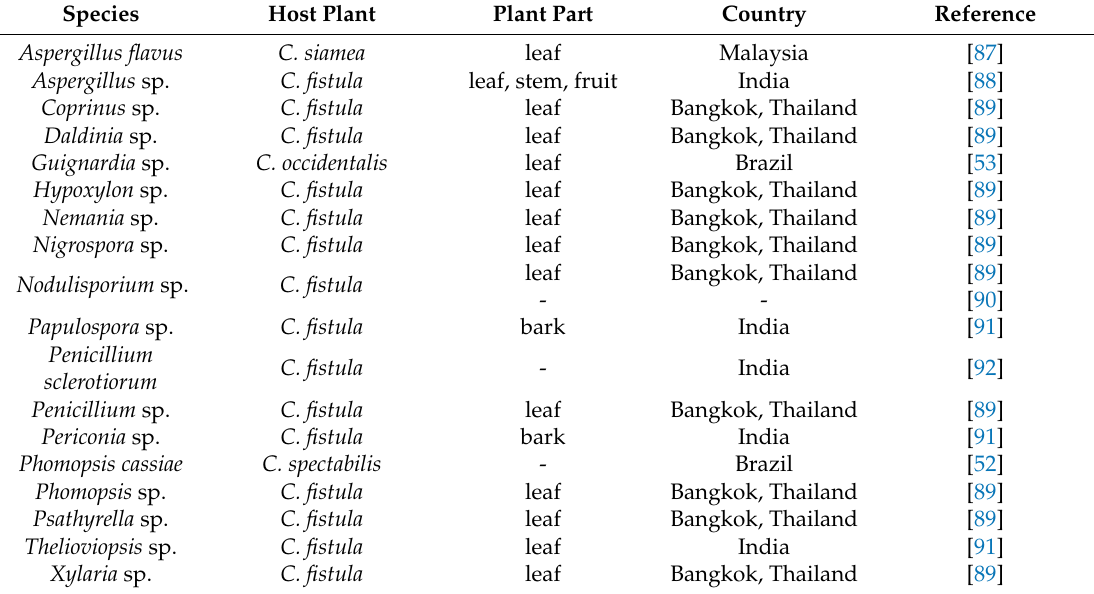
Table 7. Endophytic fungi isolated from Cassia species. Host Plant Plant Part Country